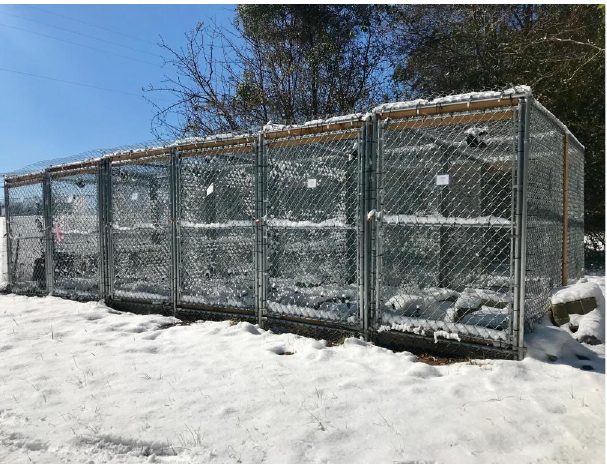
Fig 1. Outdoor soil-floor tegu enclosures in Auburn, AL. Tegus were housed in these enclosures during the late activity, winter dormancy, and early activity periods (22 August 2017–20 April 2018). Each enclosure contained an artificial refugia box buried 1 m underground and connected to the surface with corrugated drainpipe, pine straw spread on the ground, and concrete blocks lining the perimeter. Photograph taken on 17 January 2018 by MAM following an abnormal accumulating snow event in Auburn,